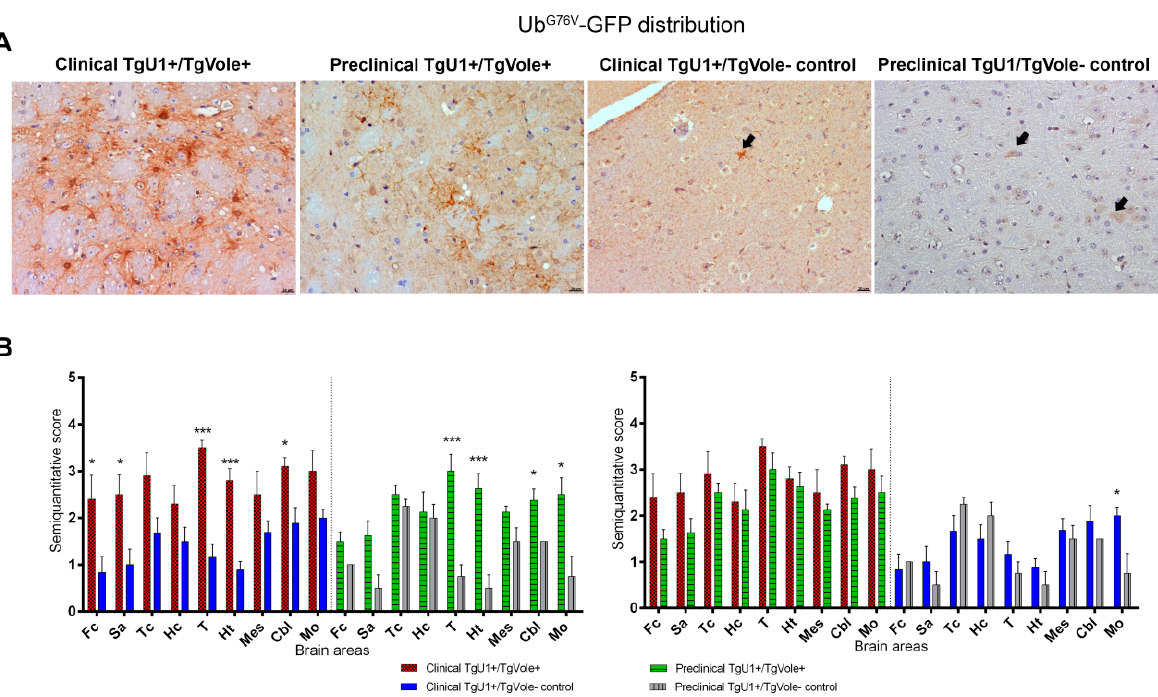
Figure 4. Ub G76V -GFP accumulation is more intense in clinical and preclinical TgU1 + /TgVole + mice than in healthy TgU1 + /TgVole − controls in certain brain areas. ( A ) Strong Ub G76V -GFP immunostaining was observed in the thalamus of clinical and preclinical TgU1 + /TgVole + mice, affecting cells whose morphology is compatible with reactive astrocytes. Healthy aged TgU1 + /TgVole − mice (clinical TgU1 + /TgVole − controls) showed granular immunostaining and filamentous ubiquitin aggregates in the neuropil (arrow). Healthy young TgU1 + /TgVole − mice (preclinical TgU1 + /TgVole − controls) showed slight intraneuronal Ub G76V -GFP immunolabeling (arrows). ( B ) Ub G76V -GFP distribution in the brains of clinical and preclinical TgU1 + /TgVole + mice and their age-matched controls. Ub G76V -GFP immunolabeling was semiquantitatively analyzed and scored on a scale of 0 (absence of immunolabeling) to 5 (very intense immunolabeling) in nine different brain areas. The number of animals within each group was: clinical TgU1 + /TgVole + n = 6 (4 female, 2 male), clinical TgU1 + /TgVole − controls n = 8 (6 female, 2 male), preclinical TgU1 + /TgVole + n = 5 (2 female, 3 male) and preclinical TgU1 + /TgVole − controls n = 5 (2 female, 3 male). Comparison of the Ub G76V -GFP immunolabeling profiles revealed significant differences between the group of clinical TgU1 + /TgVole + mice and clinical TgU1 + /TgVole − controls and between preclinical TgU1 + /TgVole + mice and preclinical TgU1 + /TgVole − controls in numerous brain areas. No differences were observed between clinical and preclinical TgU1 + /TgVole + mice. (* p < 0.05, *** p < 0.001, Mann-Whitney U test). When age-matched groups of mice were compared, a significantly increased Ub G76V